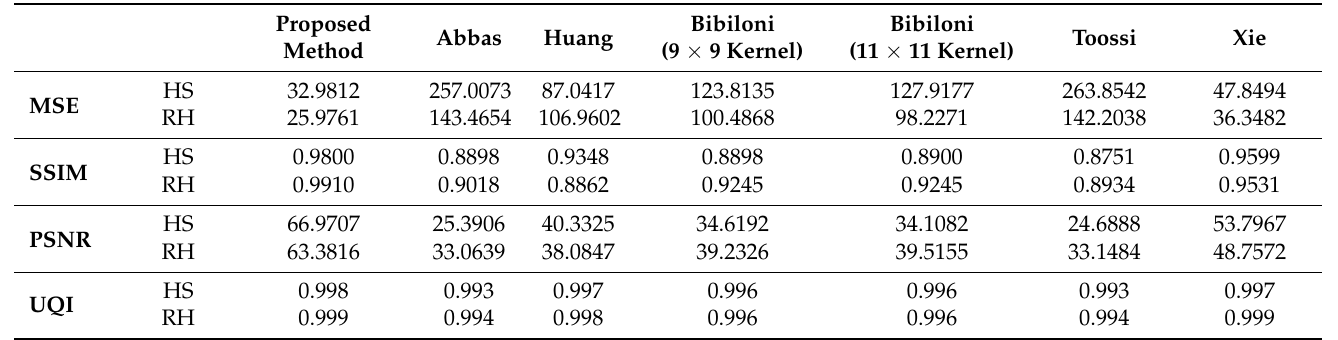
Table 4. Comparison of the proposed hair removal system against six conventional hair removal